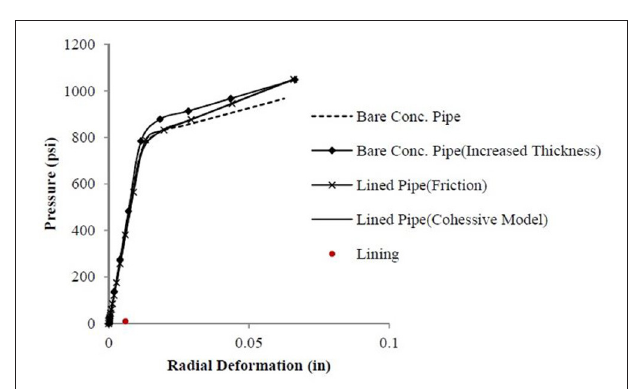
FIGURE 13 | Pressure deformation curve for bare and lined concrete pipes under uniform